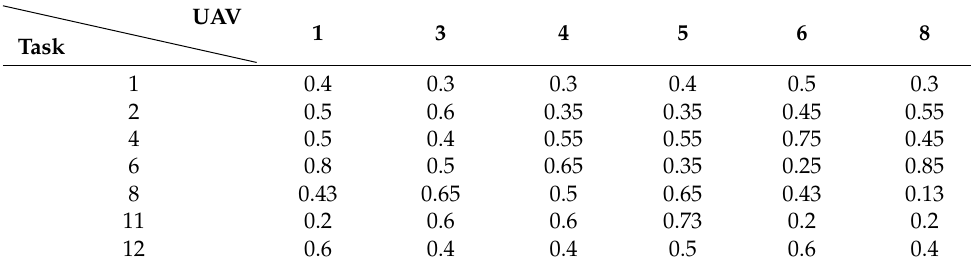
Table 3. UAV detection capability information.